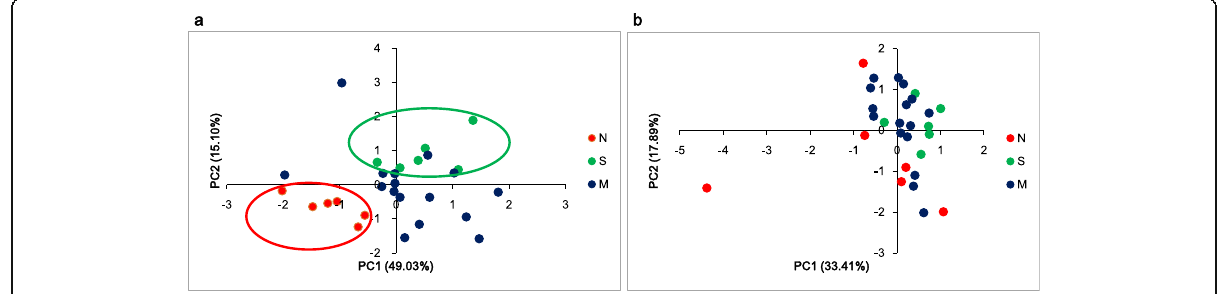
Table 1 Mantel tests for the correlation between genetic/morphological differentiation and geographic/environmental distance of rice landraces in japonica and indica groups Group